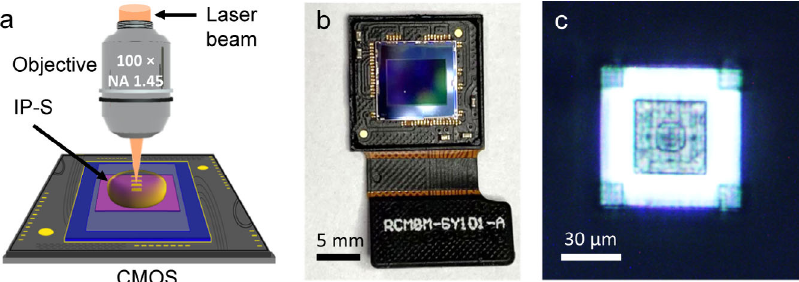
Fig. 6 | Multilayer diffractive neural networks integrated on CMOS. The nanoscale DN2 is physically 3D printed by TPN method ( a ) directly on the CMOS sensor. b PhotographoftheSonyIMX219NoIRCMOSsensorwithaDN 2 3Dprinted